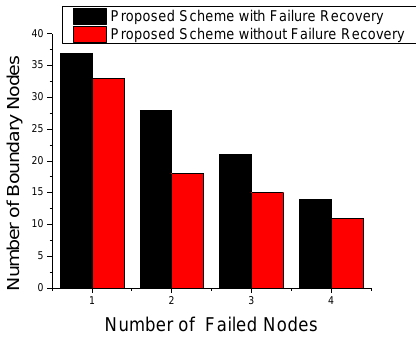
Figure 10. Effect of node failures on boundary nodes.